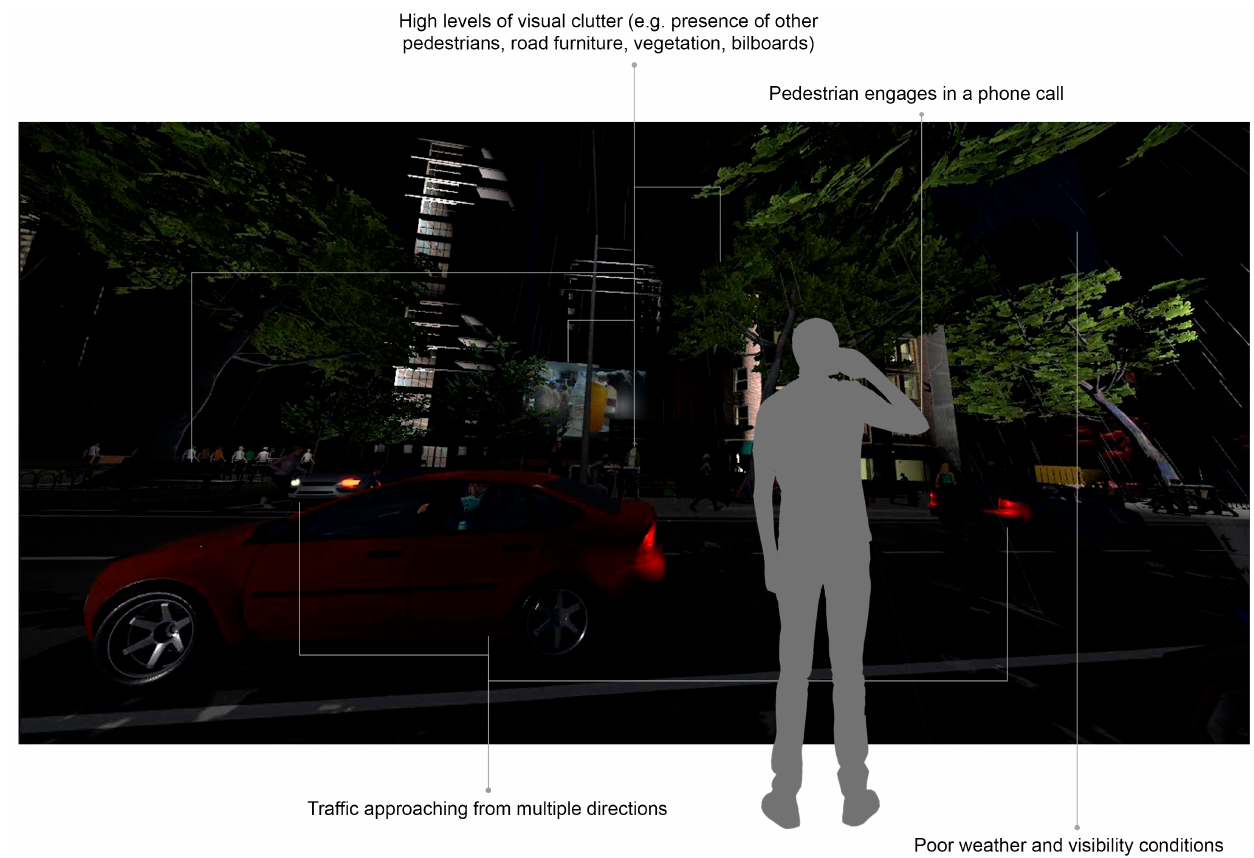
Figure 10. “Complex” simulated crossing scenario for eHMI testing. The scenario consists of a road site where traffic approaches from two lanes and joins the main road from side streets, adverse weather and poor visibility conditions, high levels of clutter in the scene as well as the presence of the phone call distraction.